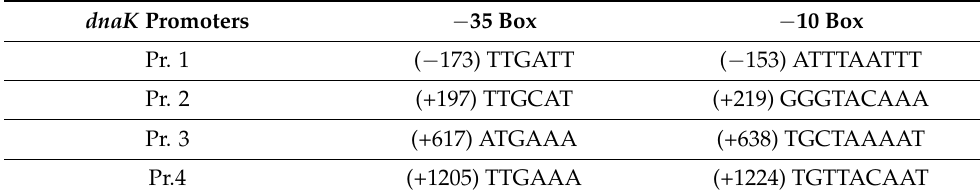
Table 2. Putative MF-I1 dnaK promoters. dnaK Promoters − 35